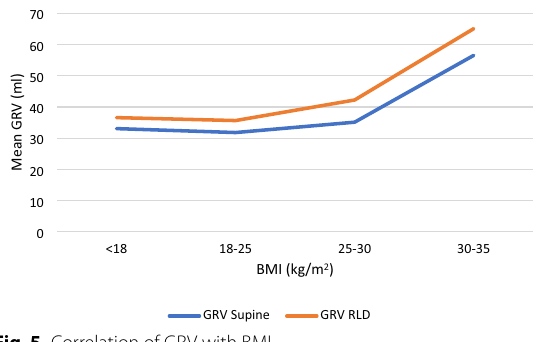
Table 4 Univariate analysis of antral grade with patient factors